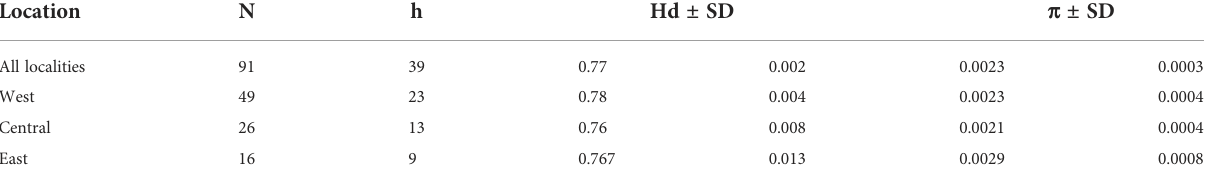
TABLE 2 Doryteuthis pleii haplotype diversity from the Yucatan Shelf, SGoM.